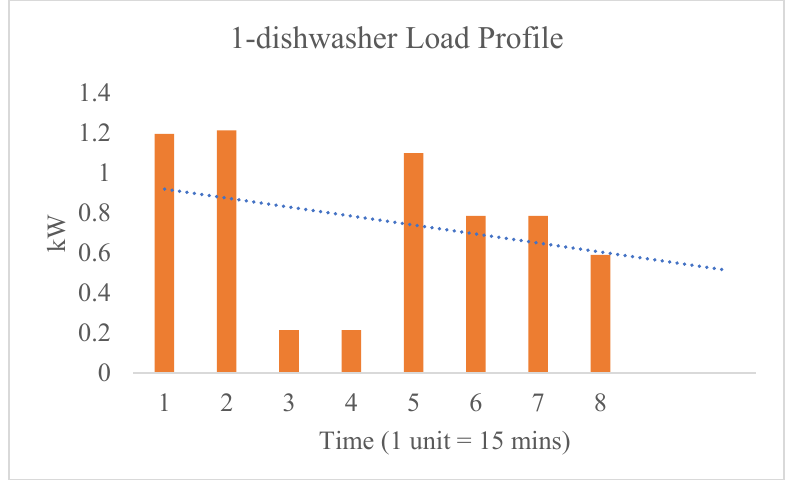
Figure 4. Dishwasher load profile.